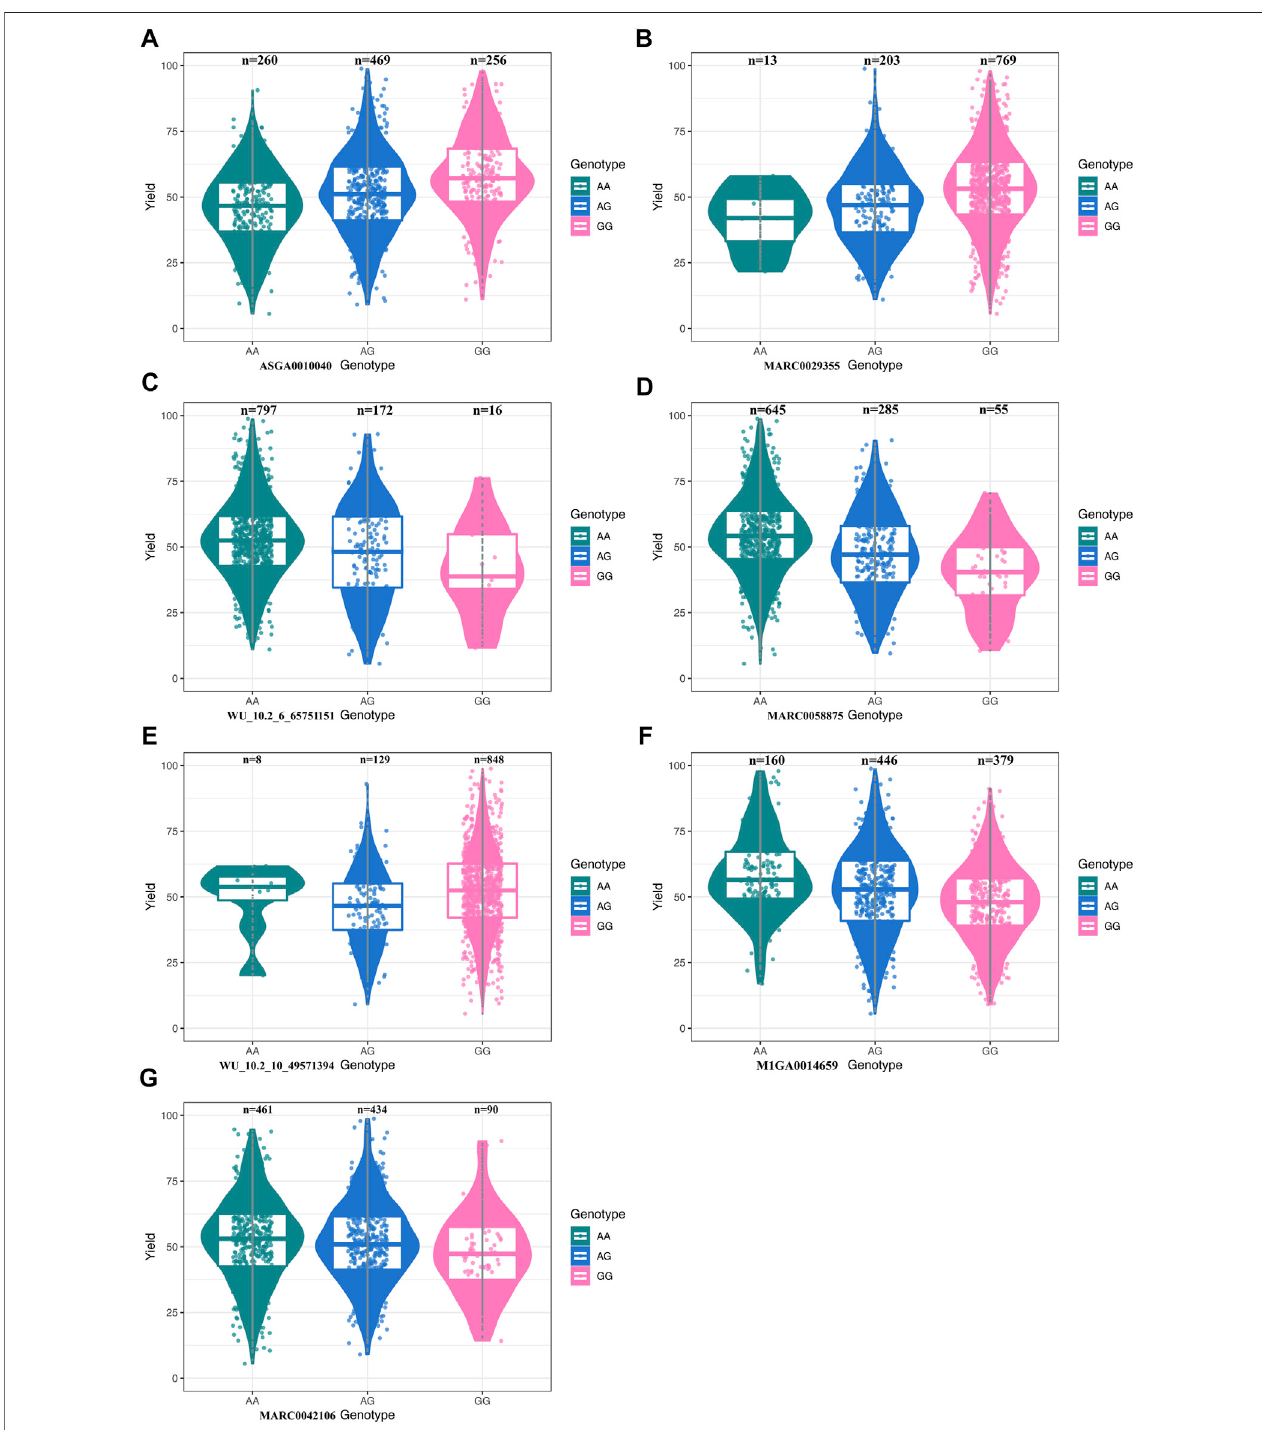
FIGURE 3 | (A) Boxplot for litter weight gain (LWG) and the genotype at SNP ASGA0010040. (B) Boxplot for LWG and the genotype at SNP MARC0029355. (C) Boxplot for LWG and the genotype at SNP WU_10.2_6_65751151. (D) Boxplot for LWG and the genotype at SNP MARC0058875. (E) Boxplot for LWG and the genotype at SNP WU_10.2_10_49571394. (F) Boxplot for LWG and the genotype at SNP M1GA0014659. (G) Boxplot for LWG and the genotype at SNP MARC0042106.